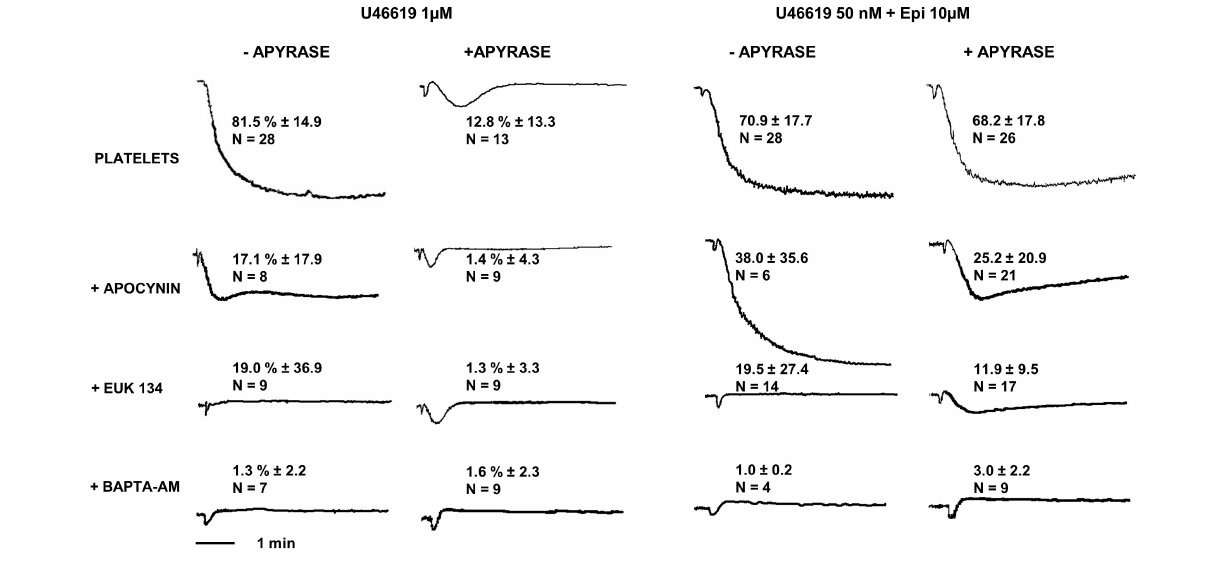
FIGURE 5 | Platelet aggregation induced by U46619 1 µ M and U46619 50 nM + epi 10 µ M. Washed platelets in presence or absence of apyrase VII were pre-treated with the NADPH oxidase inhibitor apocynin 300 µ M, the reactive oxygen species (ROS) scavenger EUK-134 250 µ M or the intracellular calcium chelator BAPTA-AM 20 µ M, respectively. Data are expressed as Mean ±